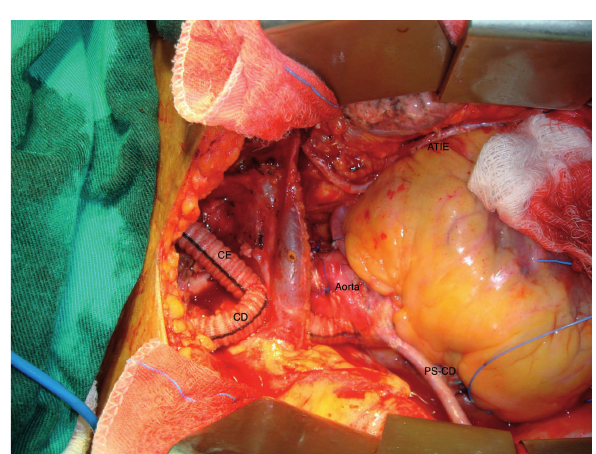
Fig. 2 - Documentação fotográfica do perioperatório. ATIE –